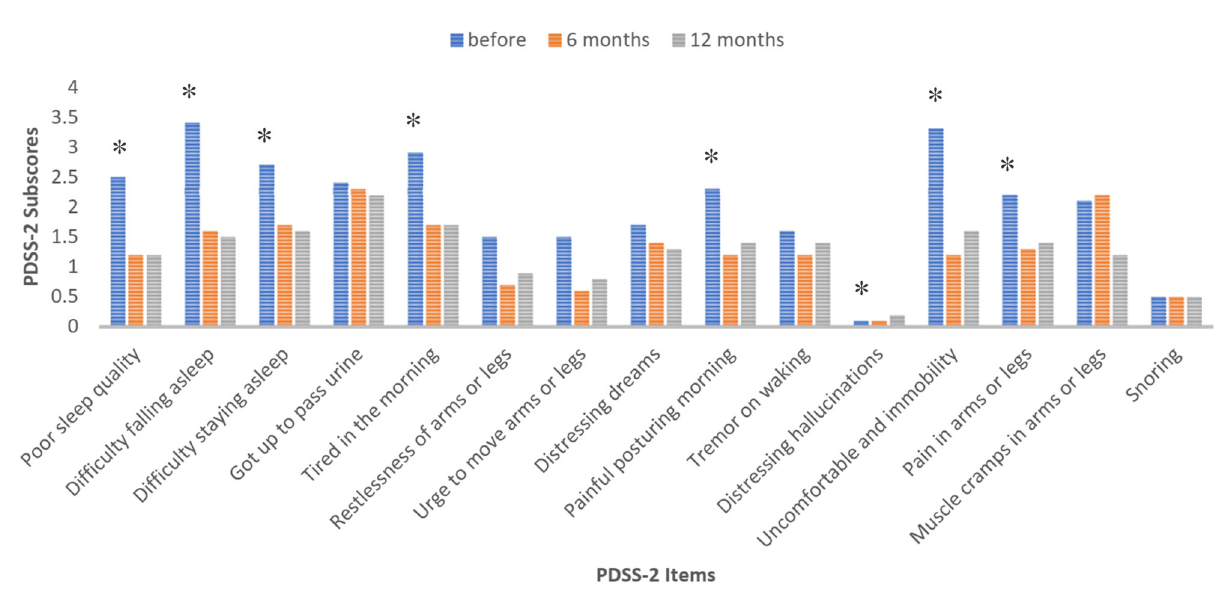
FIGURE1 Evolution of the subscores (mean values) in the PDSS-2 at the baseline, 6 and 12 months follow-up. Values with asterisk (*) were statistically significant ( p < 0.05), Friedman